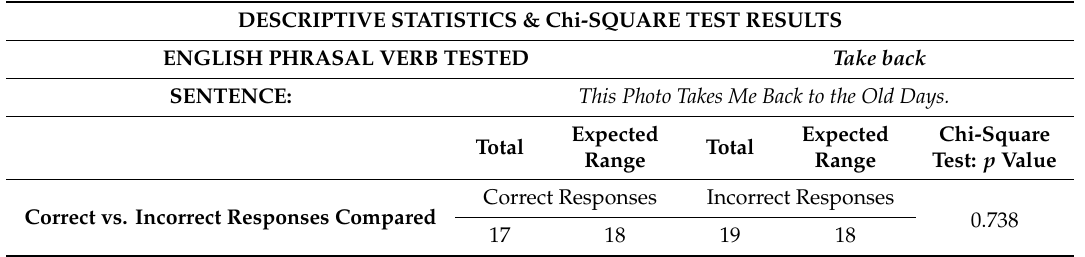
Table 12. p values for take back